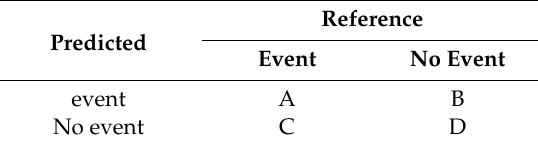
Table 3. Confusion matrix for 2 × 2